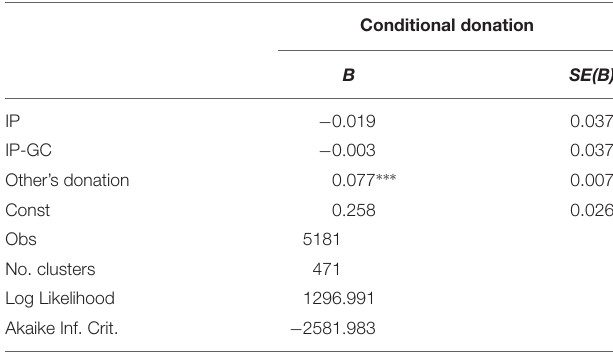
TABLE 7 | Effect of identity priming, goal commitment and level of others’ donation on conditional donation, Study 2.